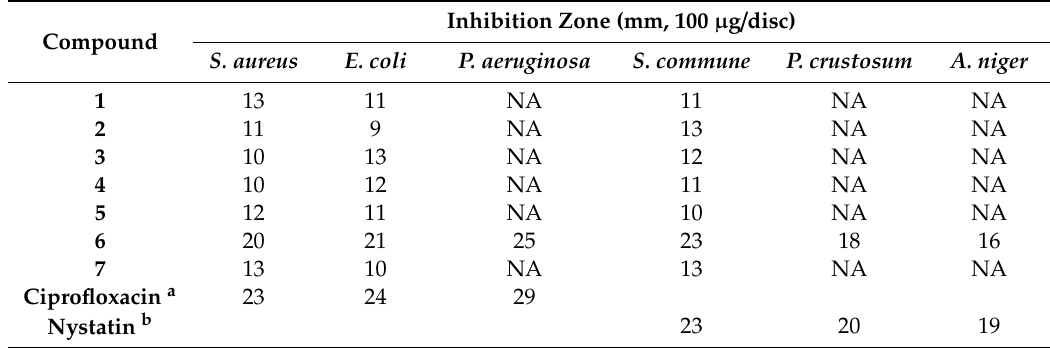
Table 3. Antimicrobial activities of compounds 1 – 7